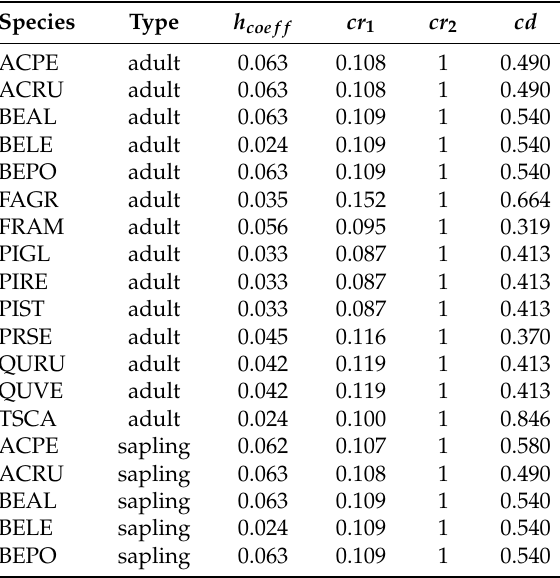
Table A1. Species crown allometry